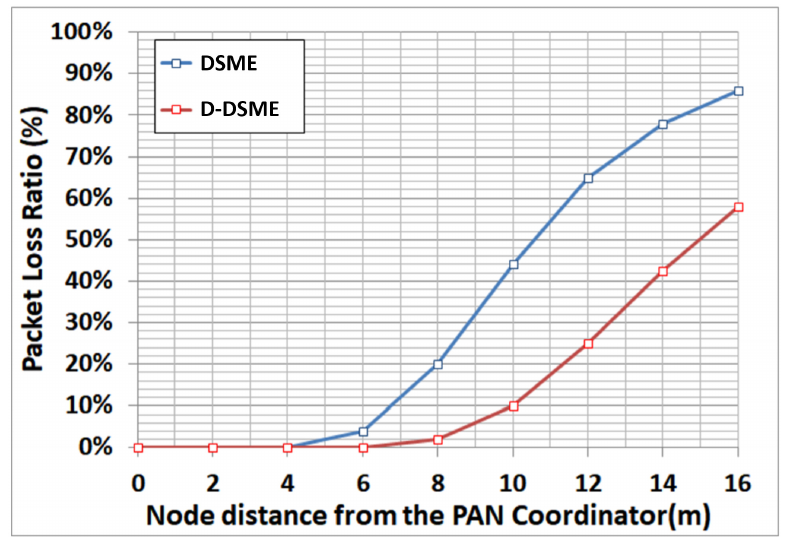
Figure 5. Packet Loss Ratio